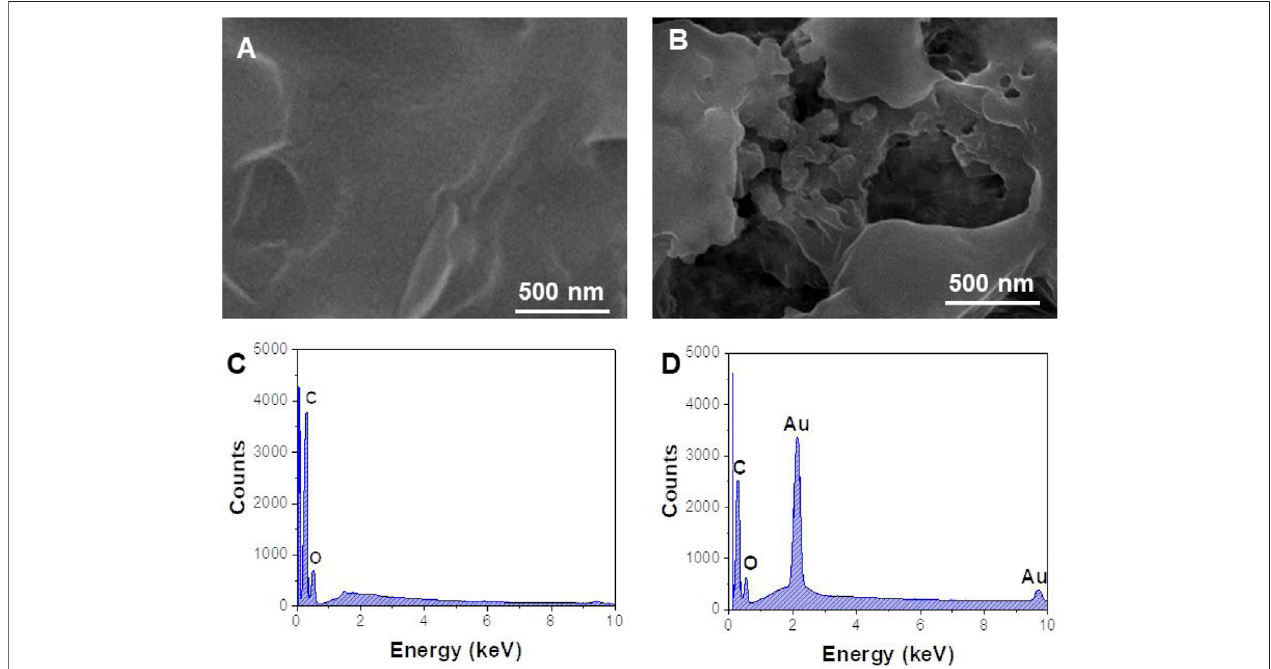
FIGURE 2 | SEM image of (A) rGO and (B) AuNPs/rGO. EDX spectra of (C) rGO and (D)